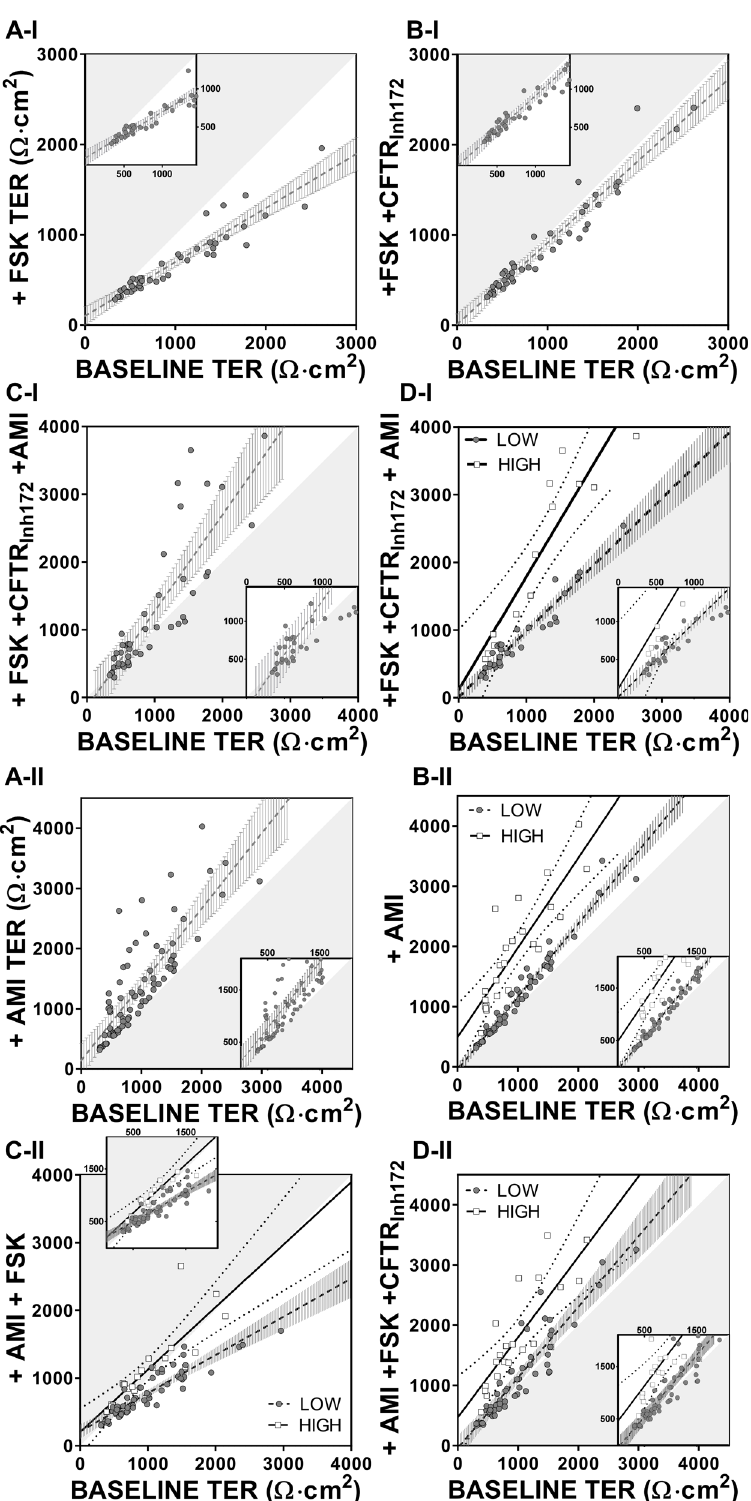
Fig 5. Drug induced effect on TER with respect to the initial baseline. TER values at baseline are plotted against values obtained after the cumulative addition of the different drugs. The hypotenuse of the shaded triangular area represents the line of identity, while magnifications are shown in the box inserts. (A-I)